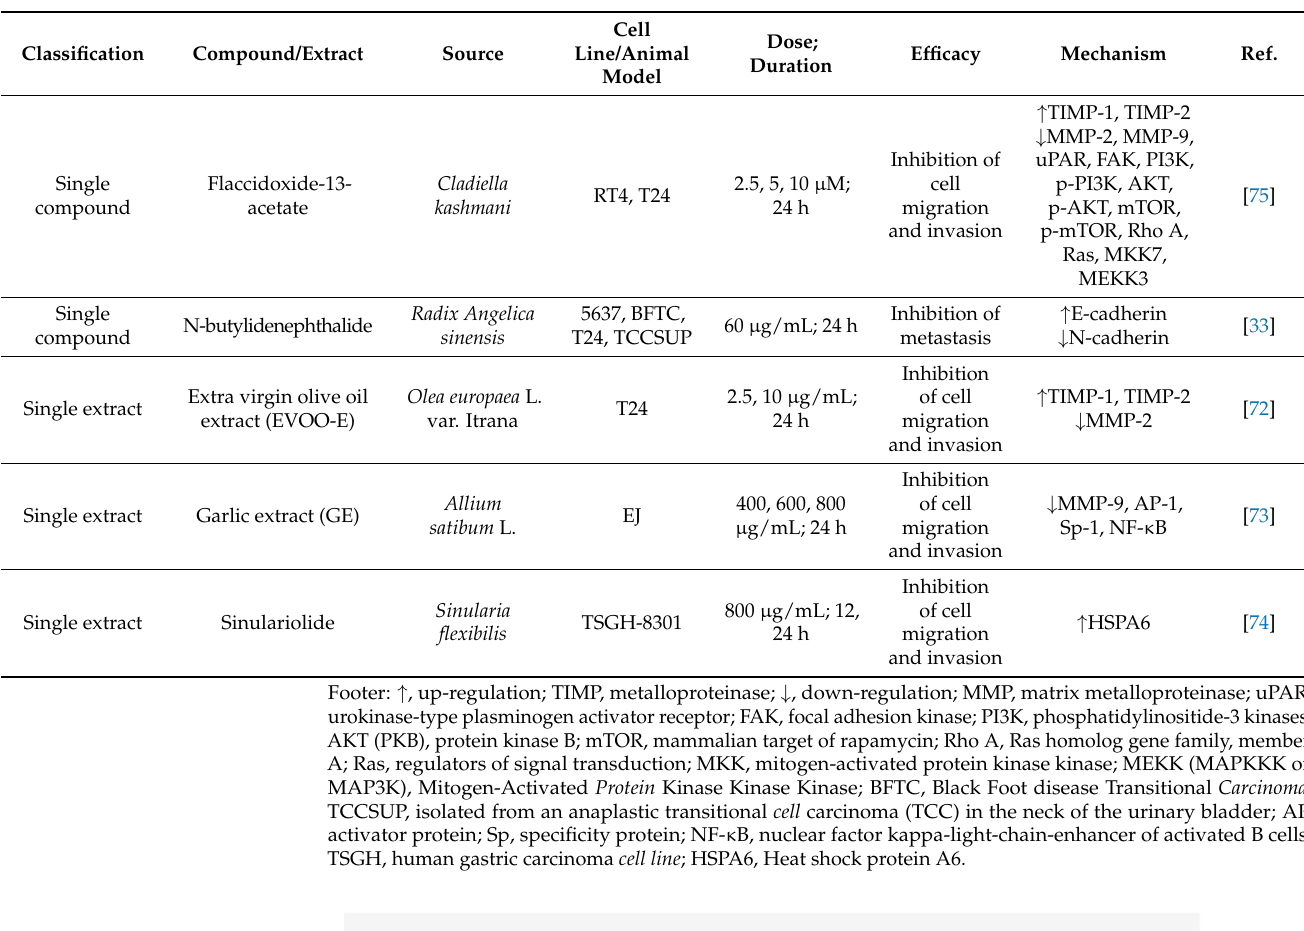
Table 4. Natural products inhibiting metastasis.